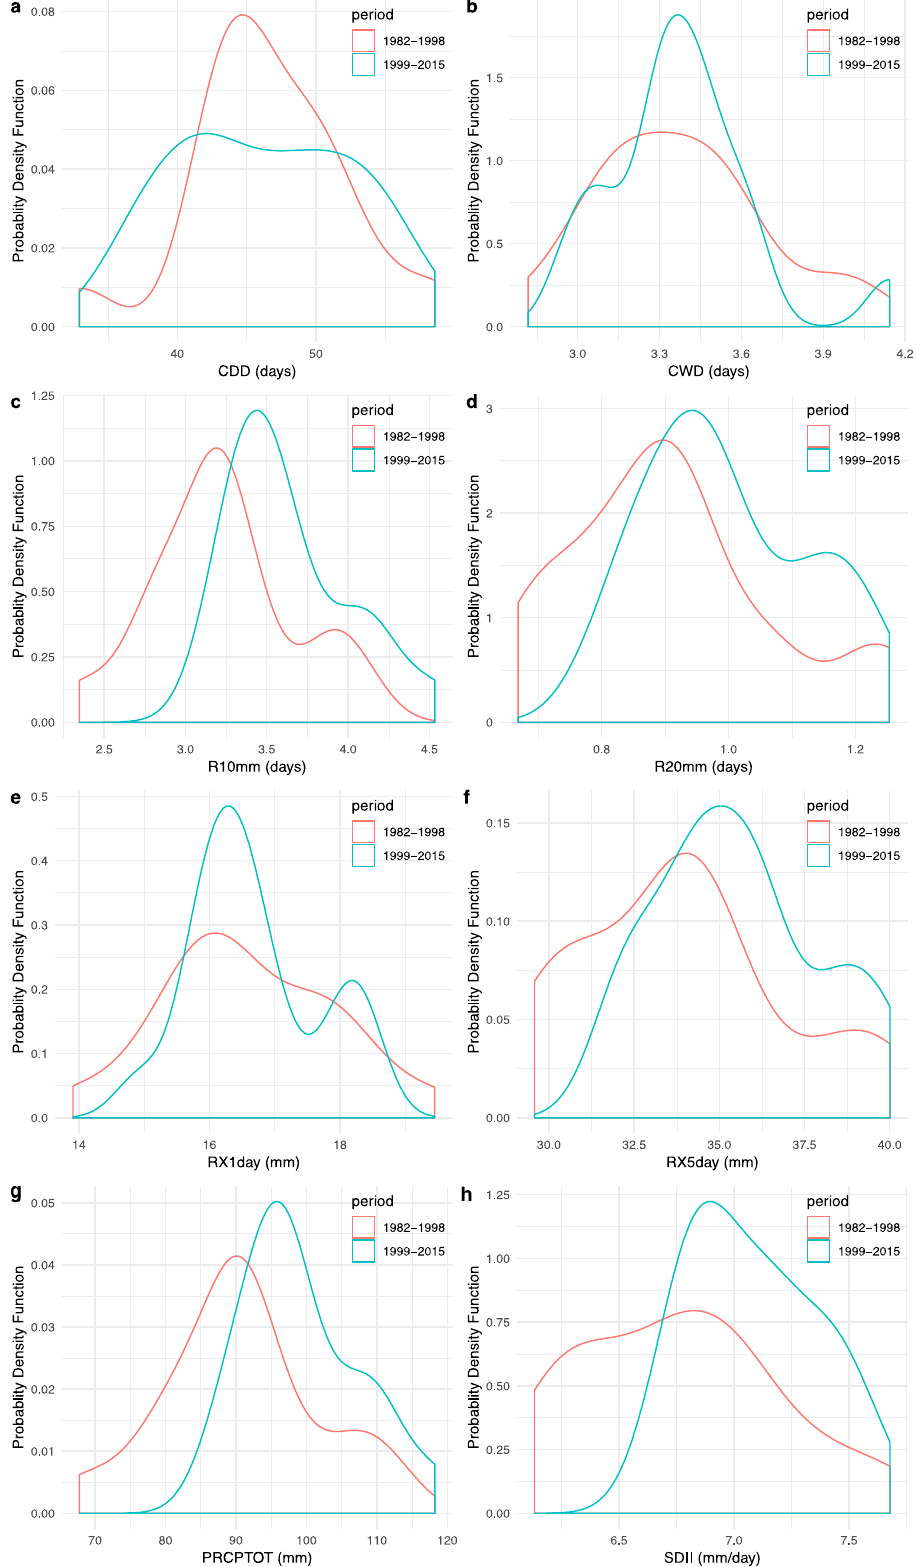
Figure 3. Seasonal (JJAS) probability density function for extreme precipitation indices over Sahel from 1982 to 2015 for two periods: 1982–1998 and 1999–2015. ( a ) CDD (days), ( b ) CWD (days), ( c ) R10mm (days), ( d ) R20mm (days), ( e ) Rx1day (mm), ( f ) Rx5day (mm), ( g ) Prcptot (mm) and ( h ) Sdii (mm /